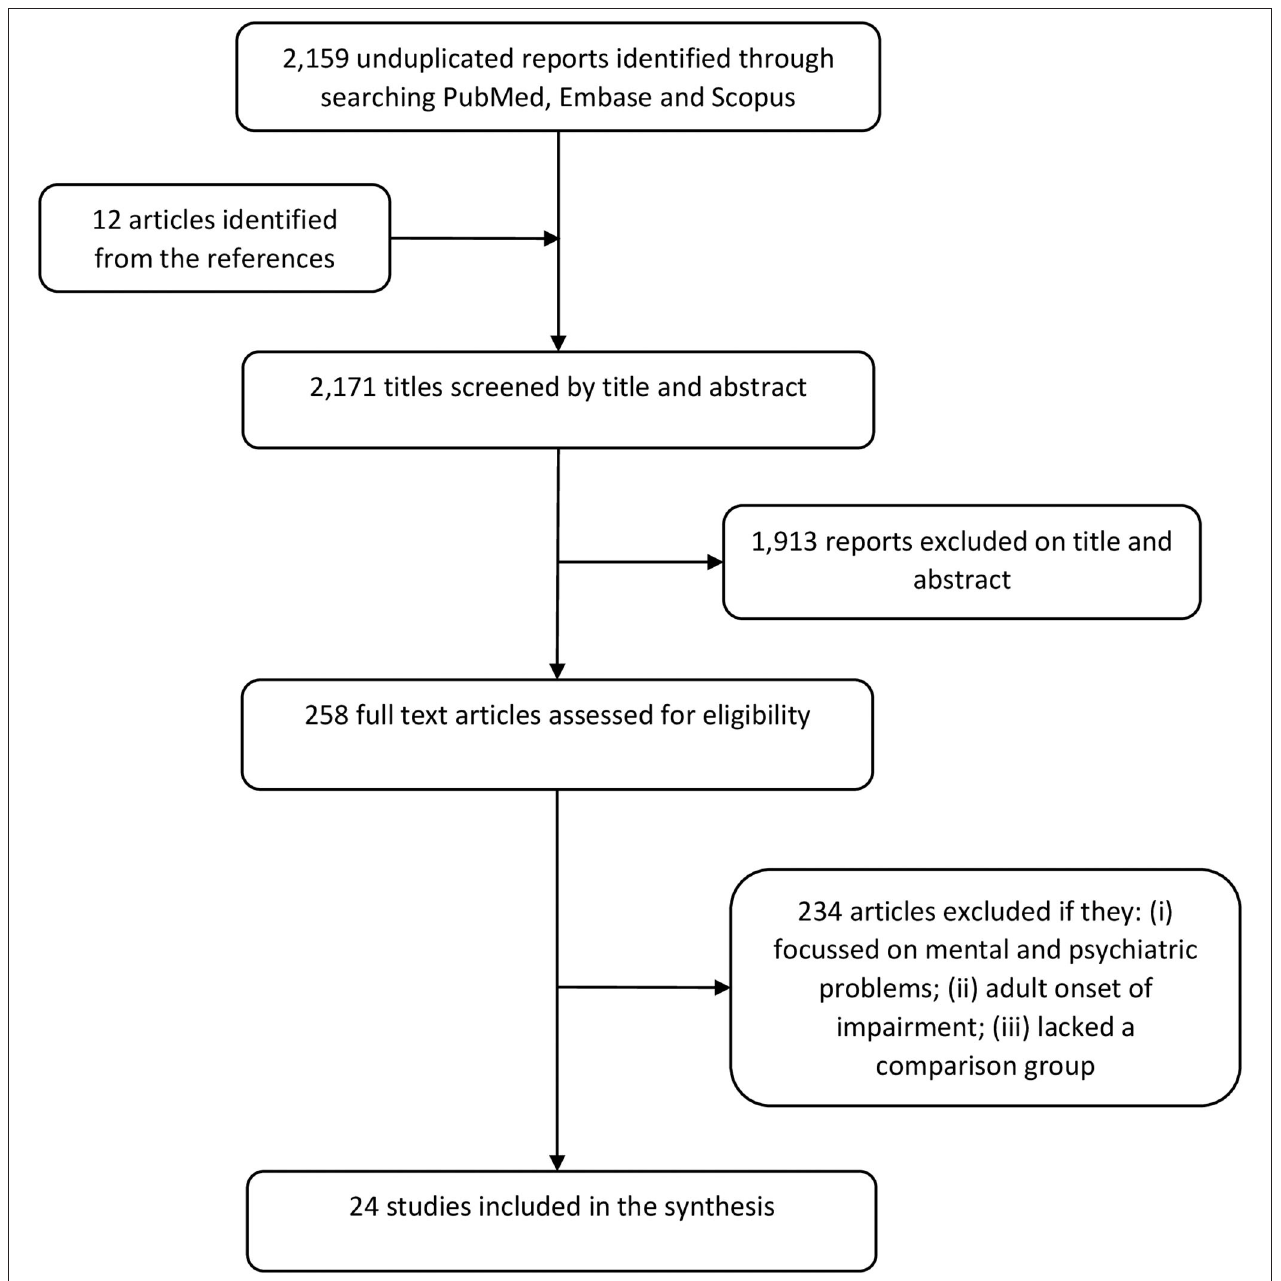
FIGURE 1 | PRISMA flowchart summarizing the systematic literature search.